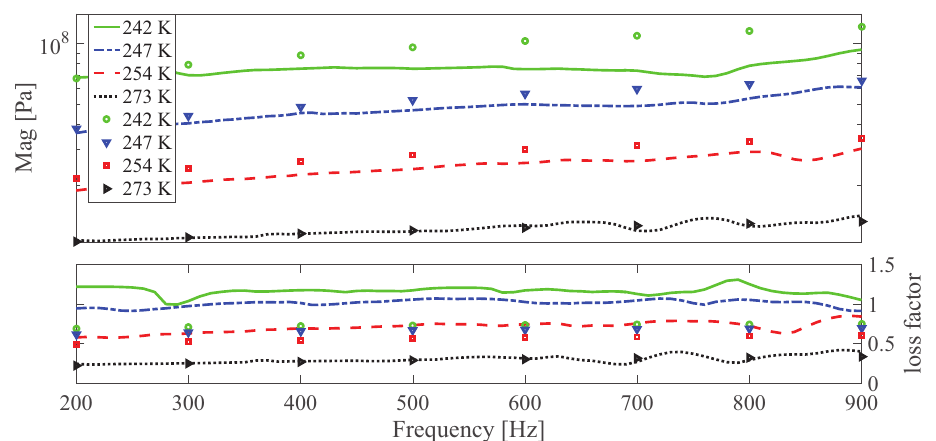
Figure 15. The magnitude and loss factor of the dynamic shear modulus versus frequency at 0.005 strain amplitude and 0.55T magnetic field under different temperatures. Lines and symbols are the simulation and measurement results,